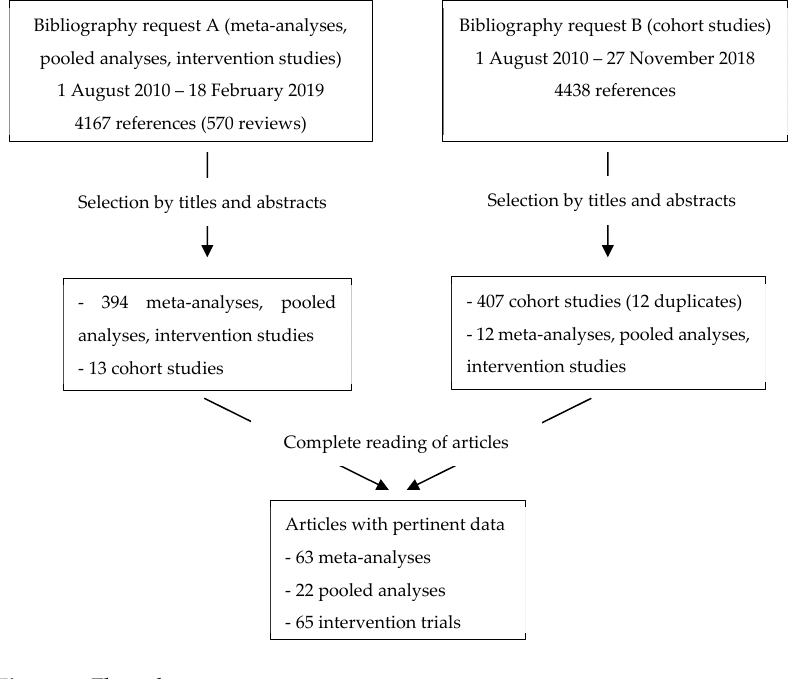
Figure 1. Flow chart. Table 2. (color). Levels of evidence for the associations between nutritional factors and clinical events during and after cancer for different